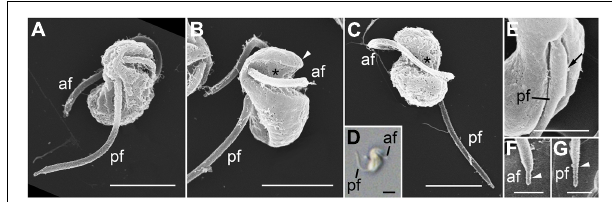
FIGURE 4 | Scanning electron microscopy (SEM) (A–C,E–G) and differential interference contrast (DIC) (D) images of the zoospore of Pararosarium dinoexitiosum . (A) Lateral view of a zoospore showing the anterior flagellum (af) and the posterior flagellum (pf). (B) Ventral view of zoospore showing the rostrum (arrowhead), the anterior flagellum (af) with a groove (asterisk) of the cell, and the posterior flagellum (pf). (C) Dorsal view of zoospore showing the anterior flagellum (af) with a groove (asterisk) and the posterior flagellum (pf). (D) Zoospore showing sigmoid shape with the anterior flagellum (af) and the posterior flagellum (pf). (E) Posterior flagellum (pf) of zoospore showing the proximal paraxial swelling (arrow). (F) Detail of the anterior flagellum (af) showing short conical tip (arrowhead). (G) Detail of posterior flagellum (pf) showing distal shrunken end (arrowhead). Scale bars: (A–D) = 2 µ m, (E) = 1 µ m, (F,G) = 0.5 µ m.